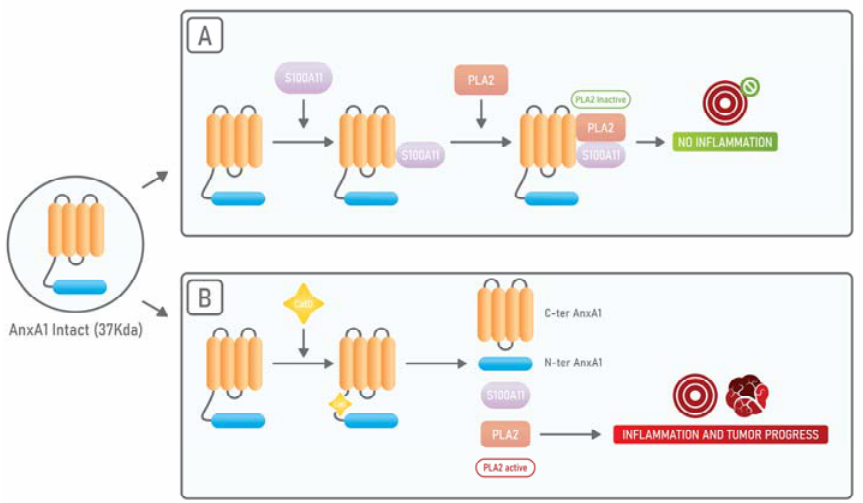
Figure 2. Schematic representation of AnxA1 cleavage and subsequent lack of inhibition of PLA 2